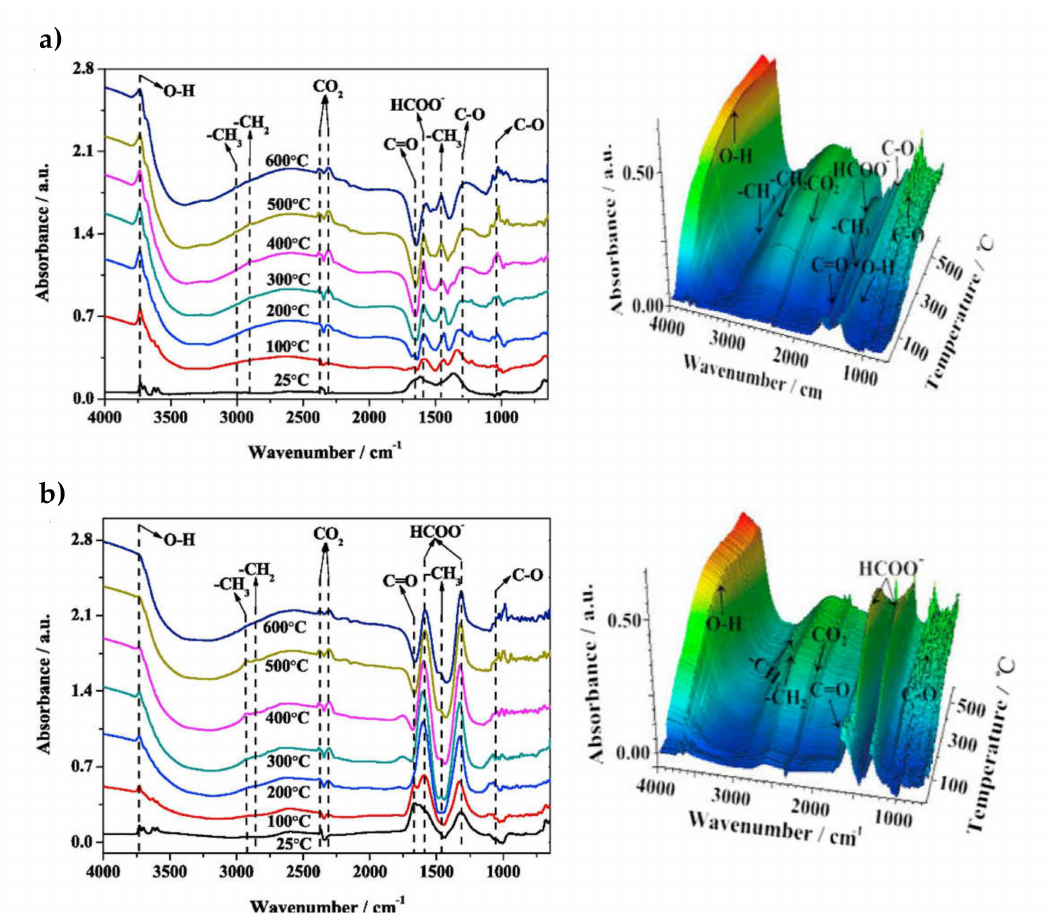
Figure 2. In-situ DRIFTS characterization for the CO 2 methanation over Ni / Al 2 O 3 and Ni-KOH / Al 2 O 3 catalysts. ( a ): Ni / Al 2 O 3 , ( b ): Ni-KOH / Al 2 O 3 . Reaction conditions: CO 2 / H 2 = 1 / 4; (CO 2 = 10 mL / min; H 2 = 40 mL / min; N 2 = 50 mL / min). Reproduced with permission from ref. [45]. Copyright 2018